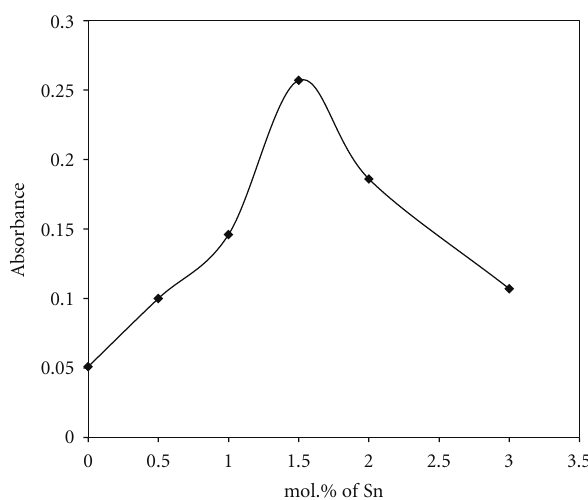
Figure 7: Hydroxyl radical amounts on Sn/TiO 2 nanoparticles with di ff erent Sn content.